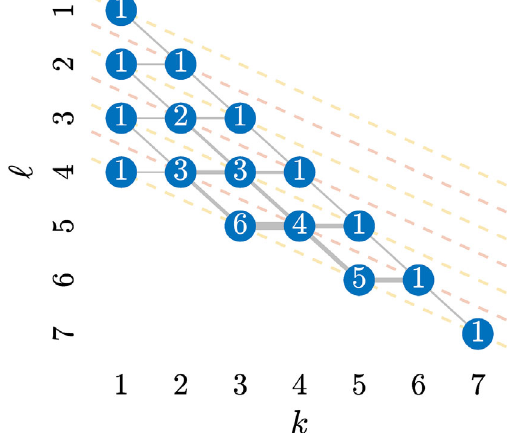
FIG. 15. Transition graph of states in perturbation theory. The states contained in the first seven orders of perturbation theory are illustrated as a graph, where each node groups states with the same k (the number of occupied sites) and l (the position of the rightmost occupied site). The number of states for fixed ð k; l Þ is indicated on each node. The thickness of each edge represents the number of transitions between states contained in the nodes via an application of RV . We notice that the graph has the structure of a Pascal triangle, where its shallow diagonals are highlighted with a dashed line. Notice that with an even (odd) number of hops along the edges from the topmost node j 1000 … i , we end up with an even (odd) shallow diagonal, colored in yellow